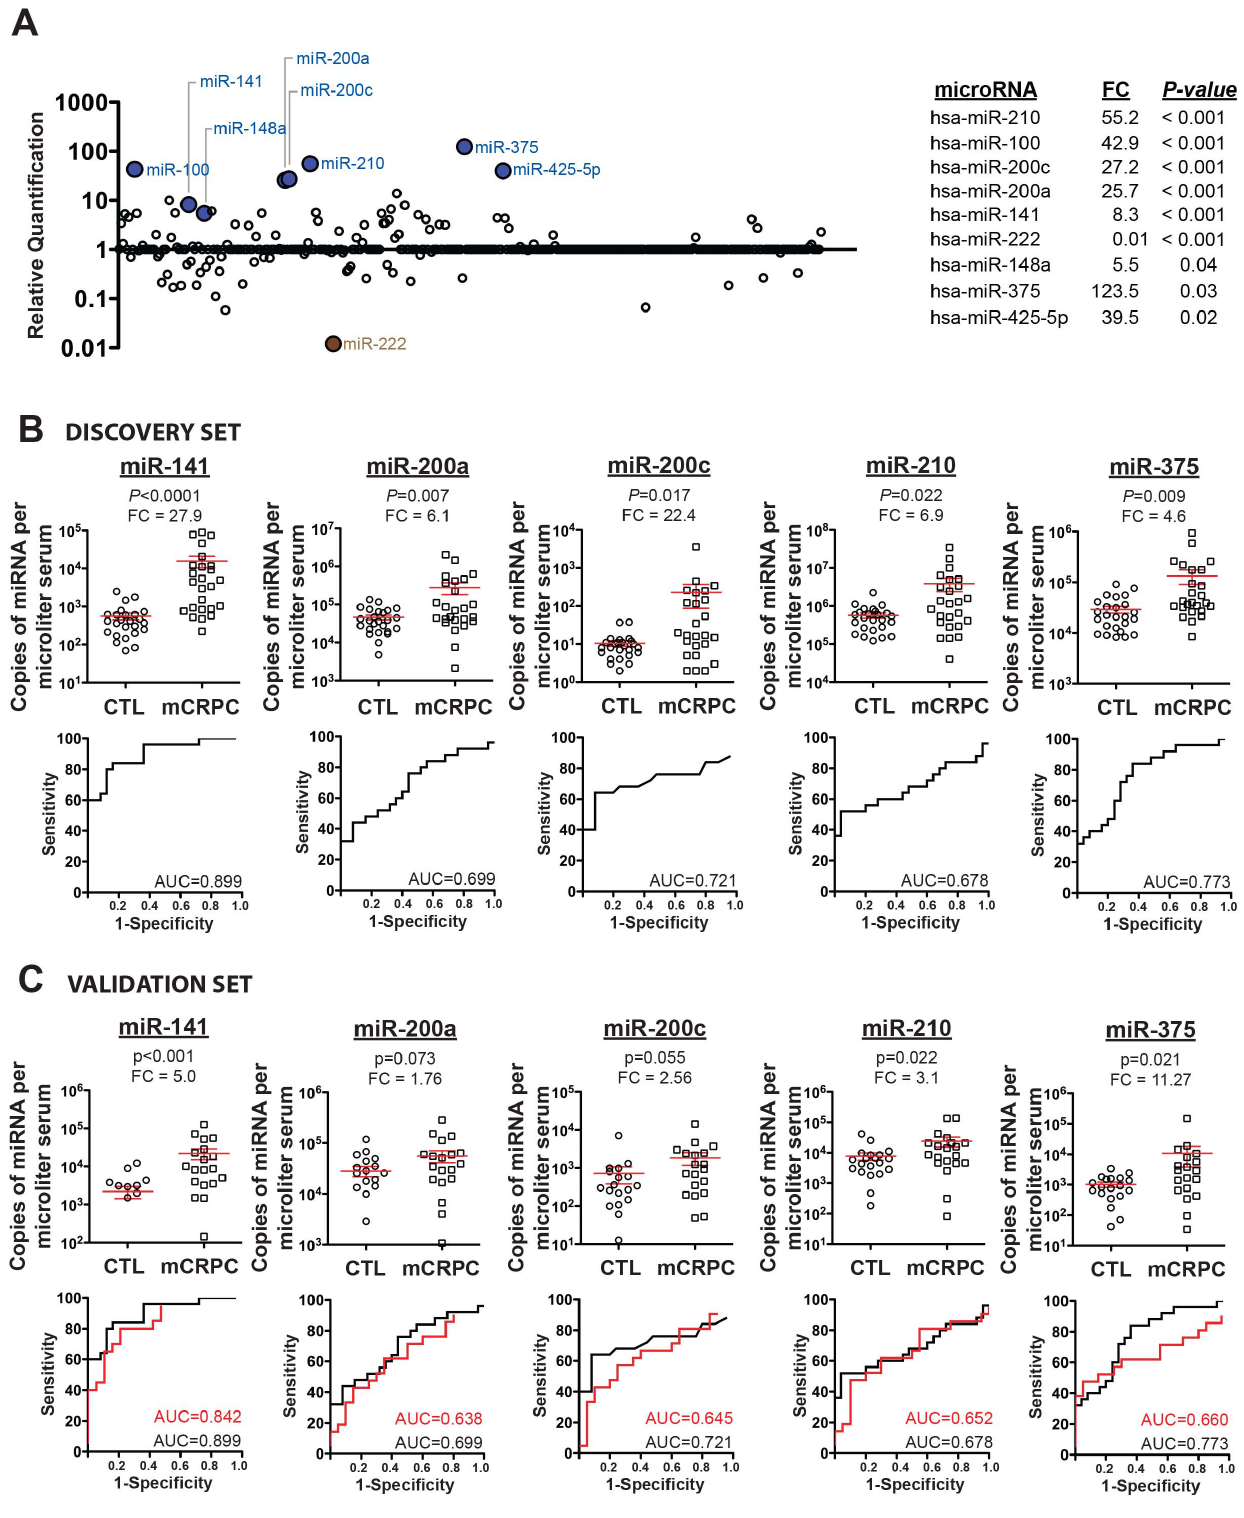
Figure 1. Serum miRNA profiling and validation. ( A) Measurement of circulating miRNAs in sera pooled from patients with advanced prostate cancer as compared to healthy donors (comprising a Discovery Set) by TLDA profiling. Blue- and brown-filled circles represent serum miRNAs increased or decreased (with unadjusted p-value , 0.05), respectively, in mCRPC patients compared to healthy controls. Inset: Nine miRNAs demonstrated . 5-fold change (unadjusted P , 0.05, Student’s t-test). FC, fold-change. ( B) Confirmation of mCRPC-associated serum miRNAs in individual samples from the Discovery Set from the University of Washington samples. Upper : miRNA biomarker candidates were measured in individual samples by TaqMan miRNA qRT-PCR ( P value assigned by Wilcoxon signed-rank test), where miRNA abundance is given in terms of miRNA copies/ m l serum. Red bars, mean + / 2 SEM of miRNA copies/ m l serum for each group. Lower : Receiver operating characteristic (ROC) curves plot